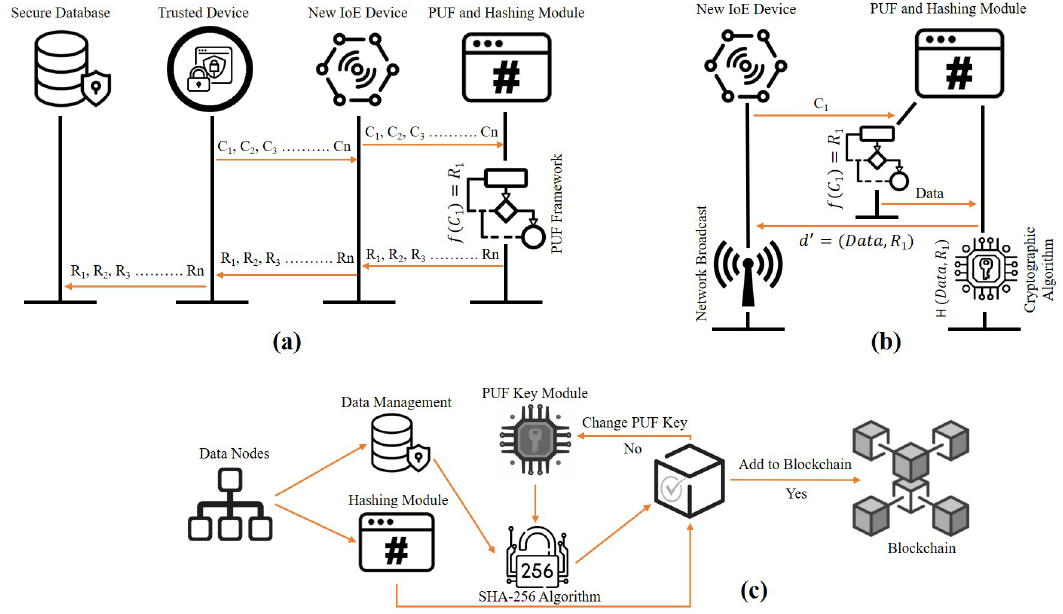
Figure 10. ( a ) Device enrolment steps, ( b ) Transactions initiation steps and ( c ) Device authentication steps in Proof-of-PUF authentication